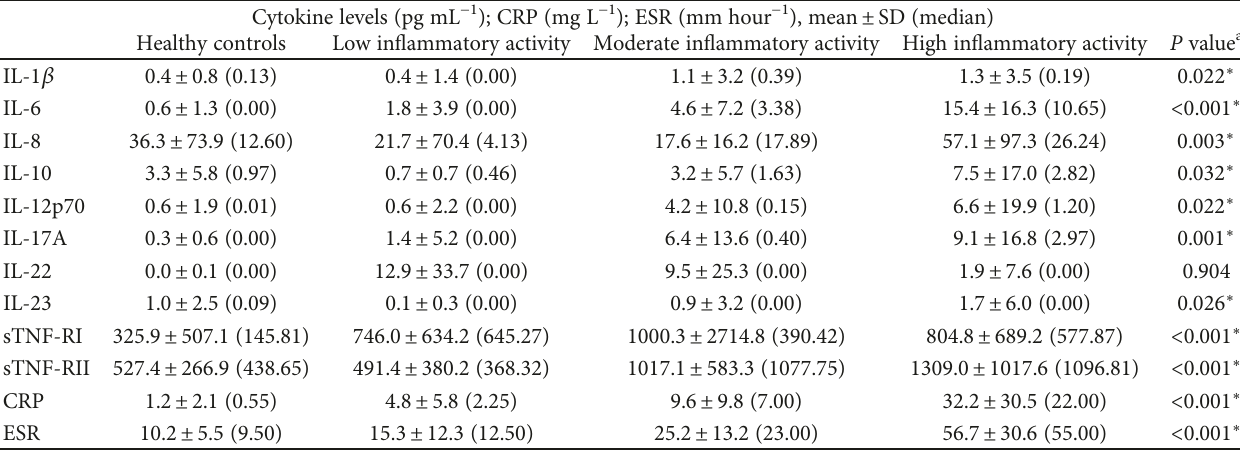
HS-PGA: Hidradenitis Suppurativa-Physician Global Assessment; IL: interleukin; CRP: C-reactive protein; sTNF-RI: soluble TNF receptor I; sTNF-RII: soluble TNF receptor II; ESR: level erythrocyte sedimentation rate. a Kruskal-Wallis test comparing the circulating levels of in fl ammatory cytokines among the healthy controls and patients with hidradenitis suppurativa according to clinical in fl ammatory activity. ∗ P < 0 05 .